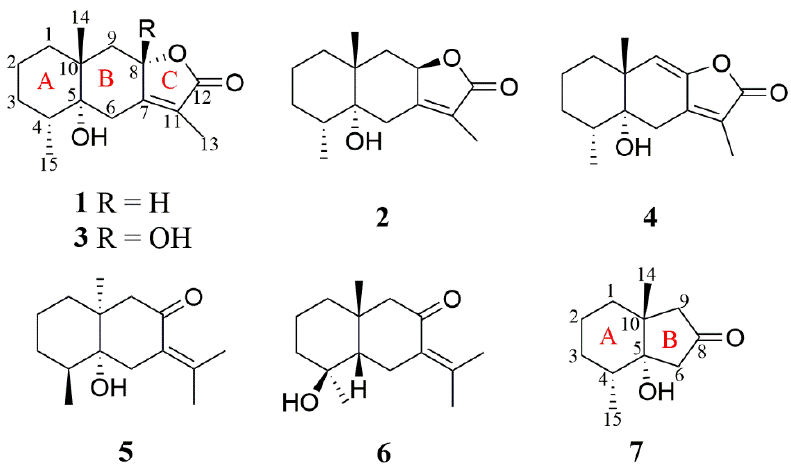
Figure 1. Structures of compounds 1 – 7 . Table 1. 1 H (500 MHz) NMR data for compounds 1 – 7 in CDCl 3 ( δ H in ppm, J in